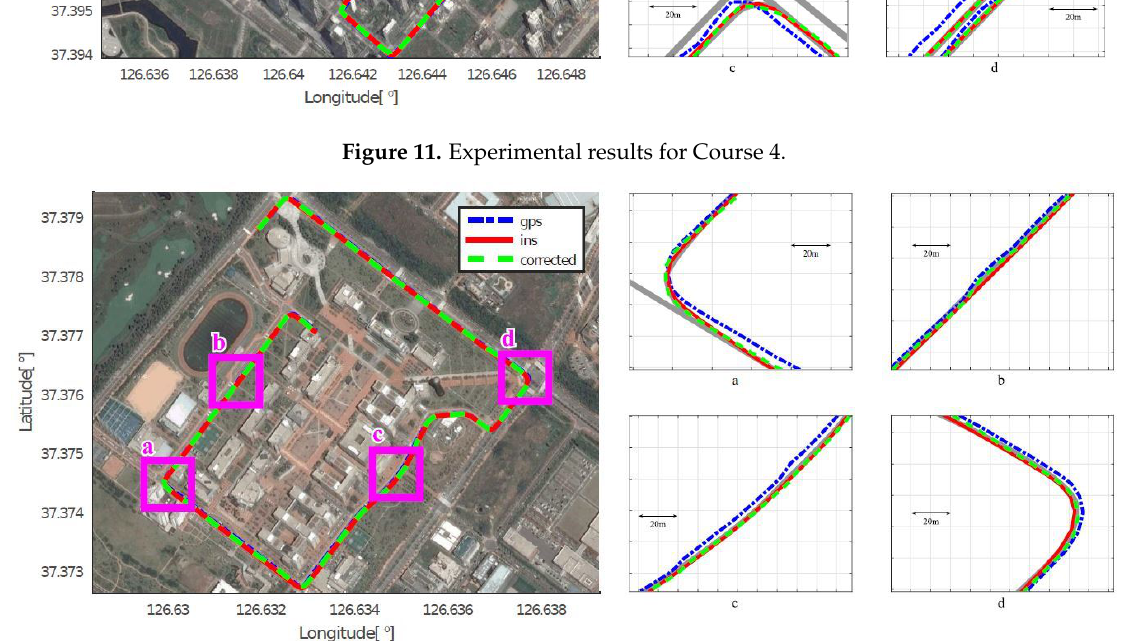
Figure 12. Experimental results for Course 5.